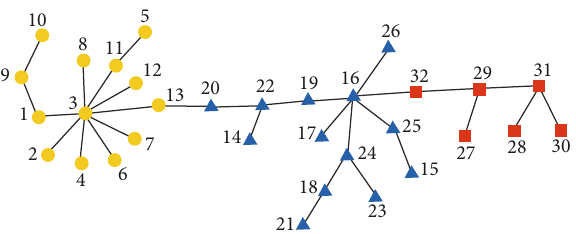
Figure 4: The MaxST of the contagion distribution for the entire crisis period. Asian and Oceanian markets are shown as yellow circles. European markets are shown as blue triangles. American markets are shown as red squares.